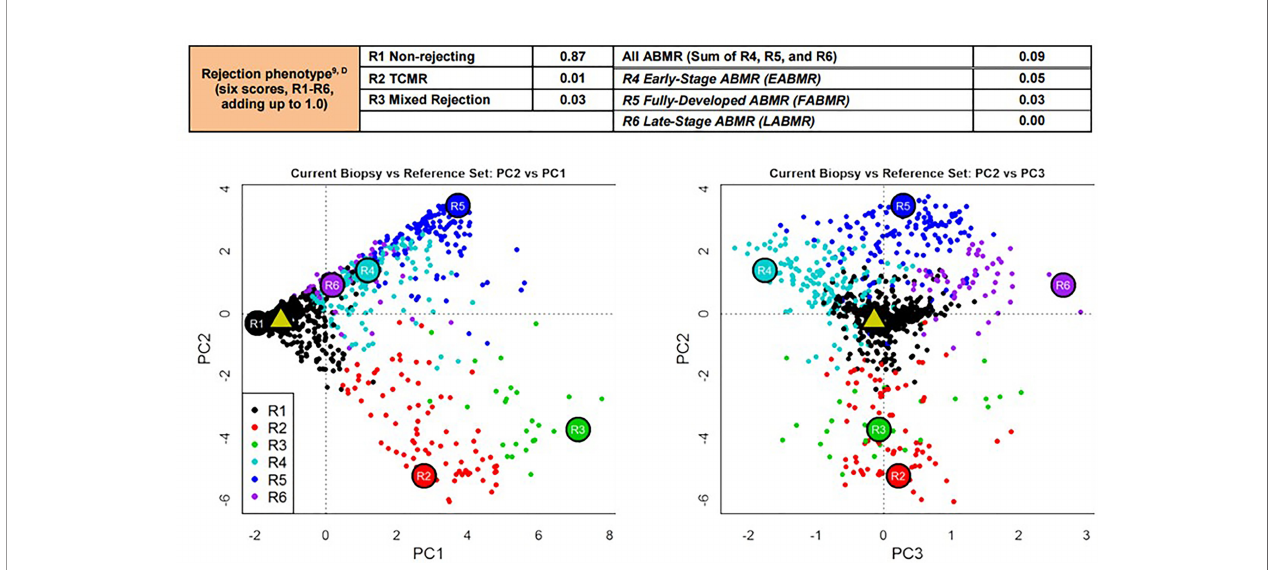
FIGURE 4 | Molecular microscope analysis of allograft biopsy no 3 in patient 2. In this analysis, an mRNA microarray of 60 genes was performed to arrive at a molecular diagnosis of T-cell-mediated, antibody-mediated or mixed rejection. This analysis was performed 18 months post-transplant under very low levels of cyclosporine monotherapy (trough level of 13 µg/L, Supplementary Figure 1 ) and showed a completely normal gene expression pattern as seen in normal kidneys from living donors (black dots are normal kidney, the green triangle represents our